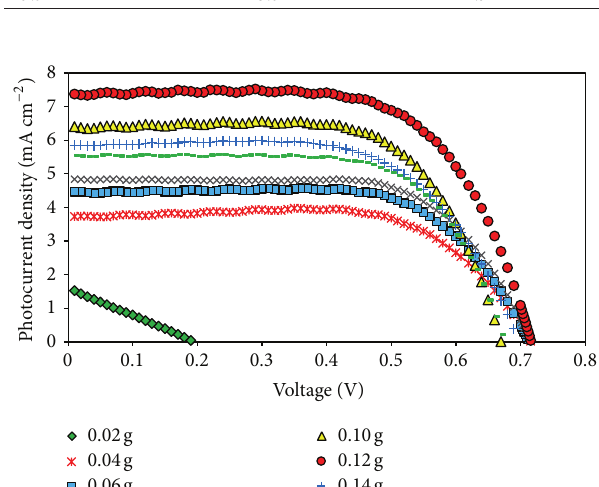
Figure 4: Effects of weight percentage of Pr 4 NI salt in the electrolyte on efficiency and short-circuit photocurrent density of DSSCs. the electrolyte containing 19.0 wt.% of Pr 4 NI with 𝜂 of